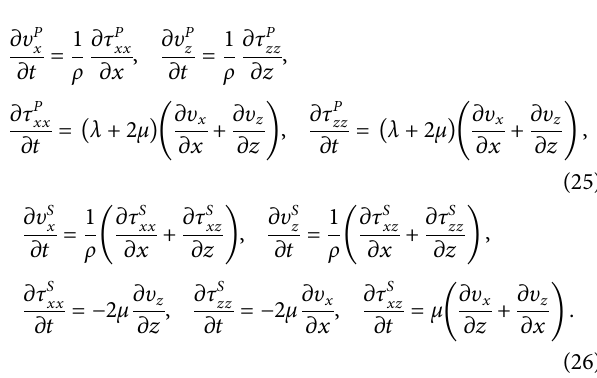
Frontiers in Earth Science |